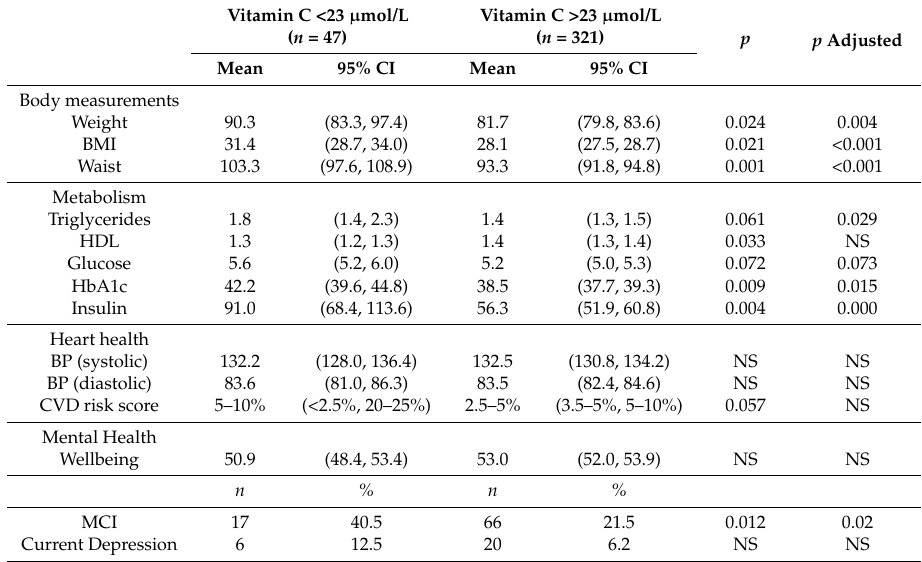
Table 4. Significant plasma vitamin C effects for body measures, metabolic health and mental